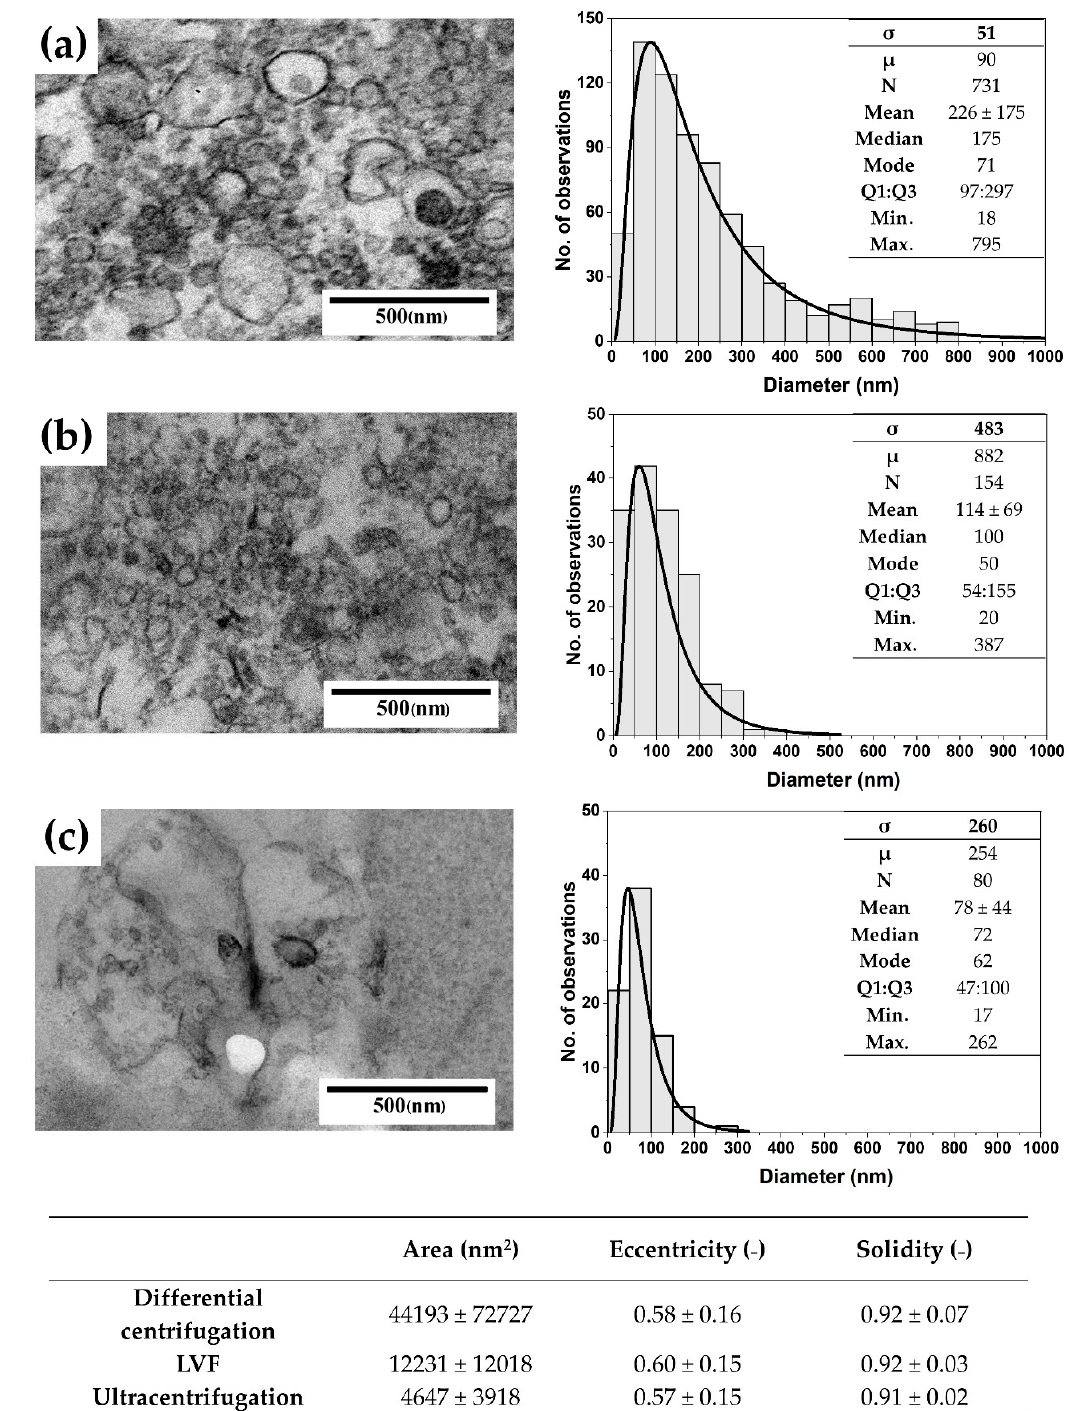
Figure 4. Representative TEM images and size distributions, with the log-normal fit parameters, for the EVs isolated using ( a ) differential centrifugation; ( b ) LVF; ( c ) Ultracentrifugation. The table below the images presents the mean area, eccentricity and solidity of the EVs obtained using these three isolation methods.